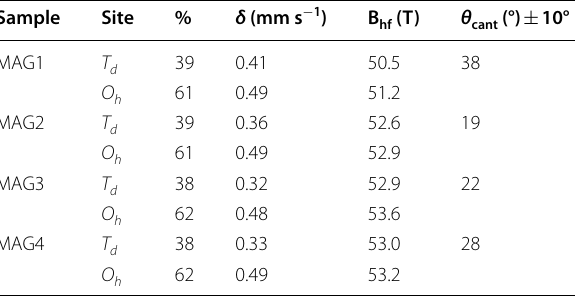
Table 3 From the fitting of Mössbauer spectra, the % area of each component, their mean individual isomer shift ( δ ), mean hyperfine field ( B ), and the average canting angle ( θ hf evaluated